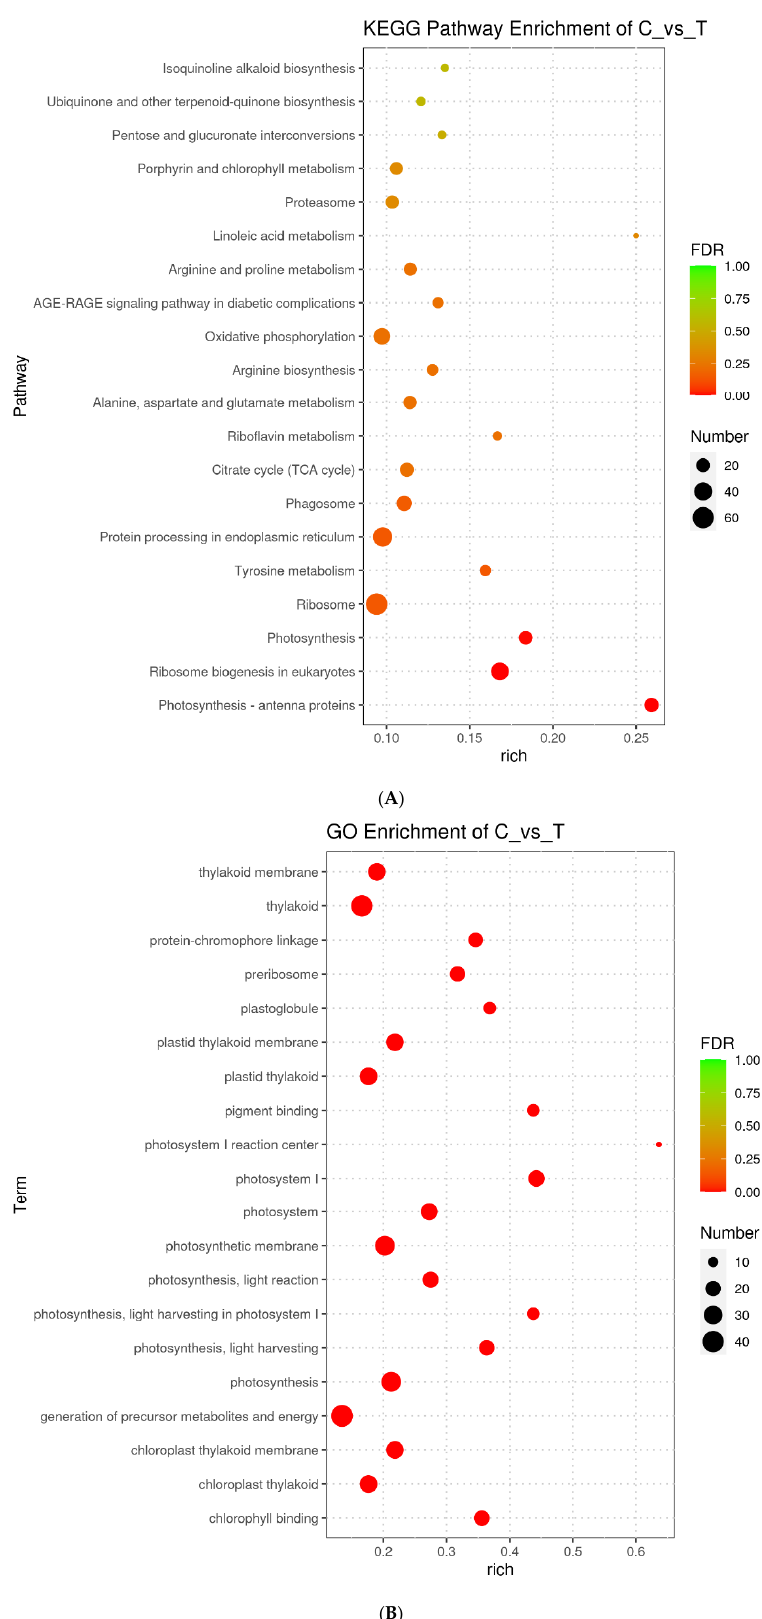
Figure 4. Scatter plots of enrichment results for the KEGG pathways ( A ) and GO function enrichment ( B ) for the IC 10 treatment of Scenedesmus obliquus compared with the control (C). The x axis shows the rich factor (the ratio of differentially expressed genes and total gene numbers of the pathway) for each KEGG or GO pathway. The color of the dot indicates the FDR value; the size of the dot denotes the number of genes involved in each pathway. The results of the GO enrichment, in terms of biological processes, are presented in Figure 5 based on the hierarchical relationship of the GO terms. The node color denotes the p -value, which decreased in the following order: of light green, yellow, orange and red. The top 10 GO terms are displayed in rectangular frames. It can be seen that light harvesting of the light reaction in PSI during photosynthesis was significantly up-regulated (14 DEGs in a total 32 of genes, p -value 2.2 × 10 − 9 ). The illustration of cellular components of the GO enrichment is shown in Figure S1A. The genes related to PSI and the photosynthetic membrane were significantly up-regulated and enriched. As for the molecular function, the genes that regulate pigment binding and chlorophyll binding were most significantly enriched.